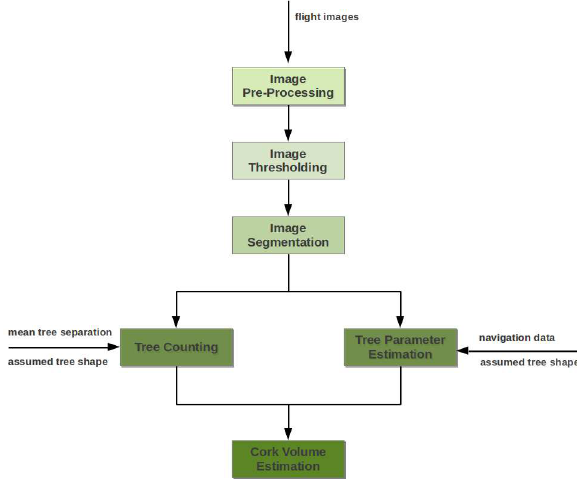
Figure 4: Cork Tree Volume Estimation from nadir imaging and post-flight navigation